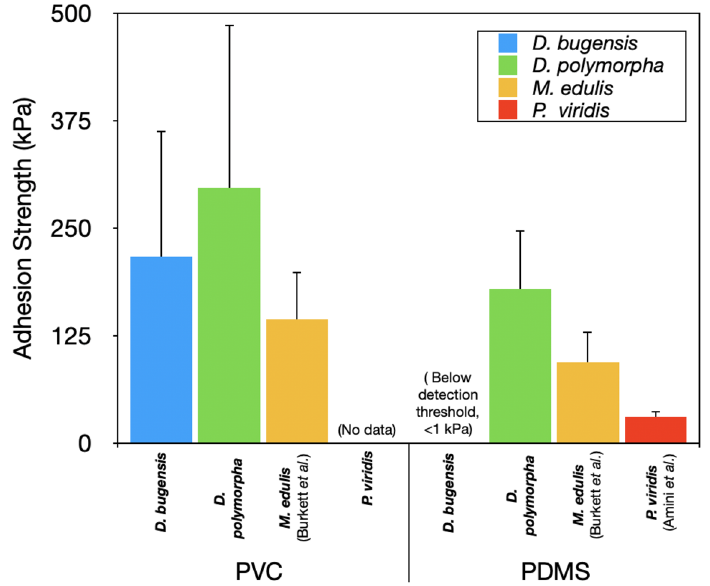
Figure 8. Interspecies comparison between freshwater and marine mussel adhesive attachment strengths. Marine mussel strength values were taken from the literature (Burkett et al. 19 for M. edulis and Amini et al. 8 for P. viridis ). Burkett et al. reported adhesive failure frequencies of 100%, 98.1%, and 0% for silicone, PVC, and glass, respectively. Amini et al. did not report failure modes. Here, for comparison purposes only, adhesion strength includes adhesive, footprint, and mixed failures, as Burkett et al. ( M. edulis ) and Amini et al. ( P. viridis ) did not distinguish between these failure modes when they conducted their detachment